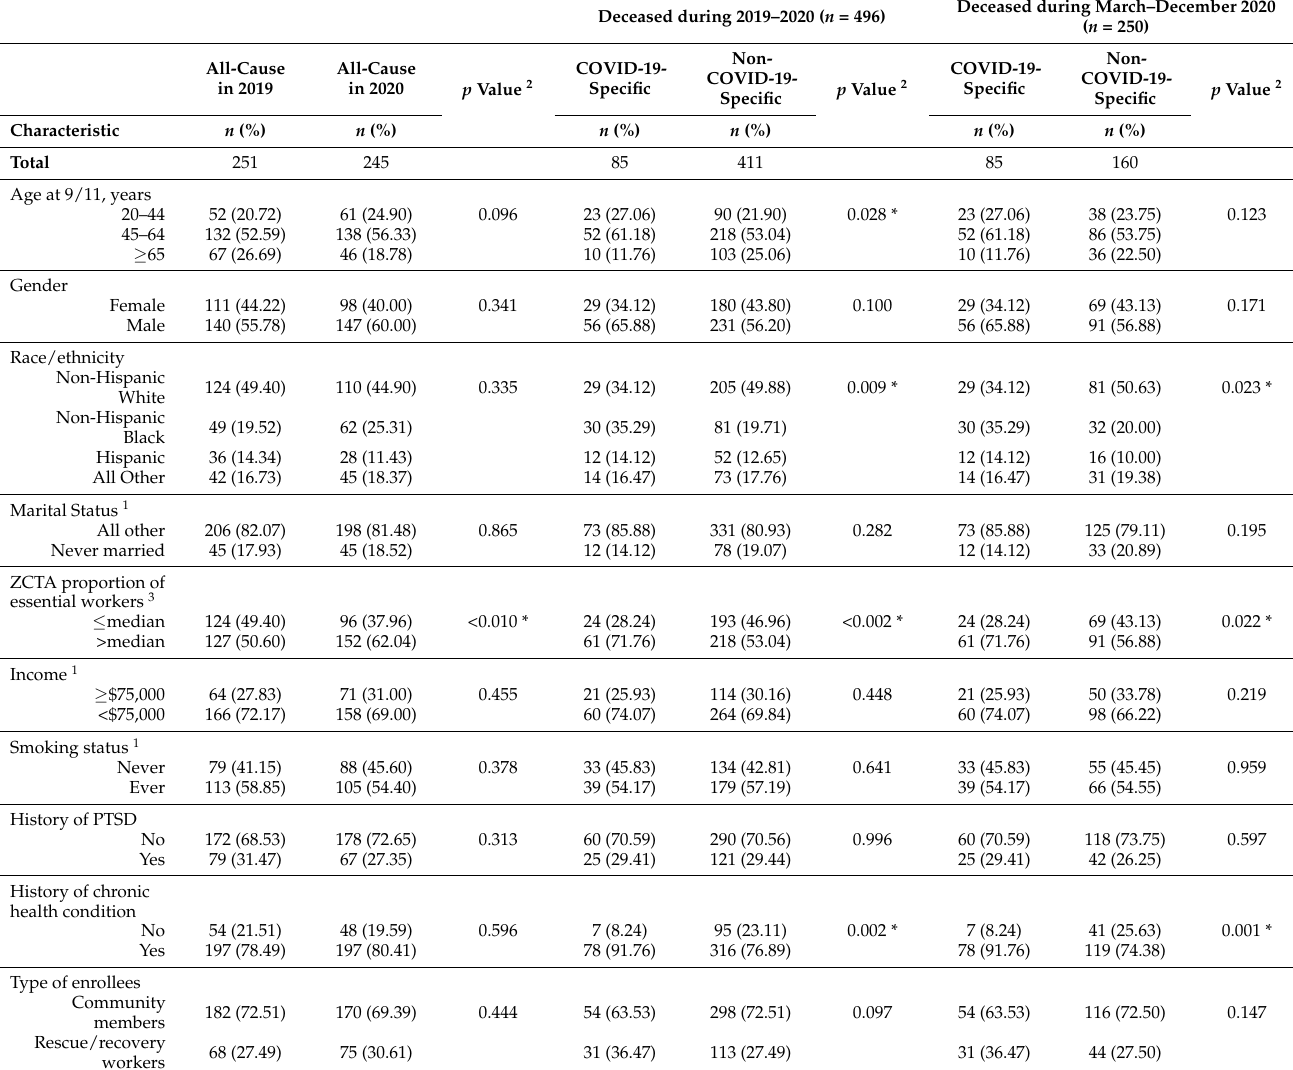
Table 2. Characteristics of Deceased in Years 2019 and 2020 by Time Periods and Cause of